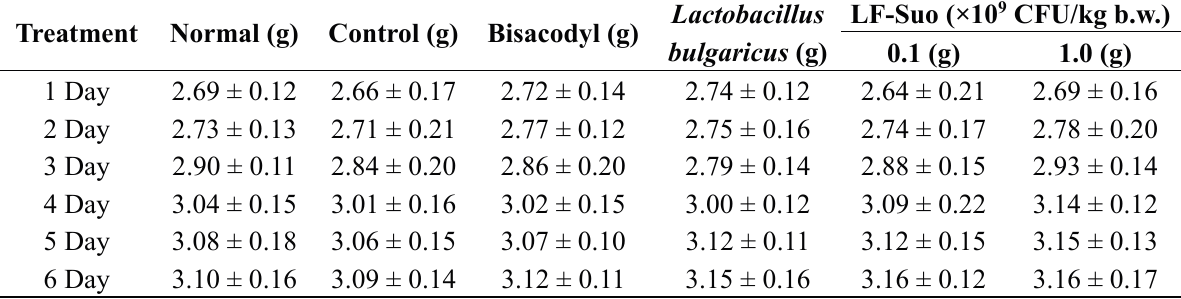
Table 2. Diet uptake of mice during the